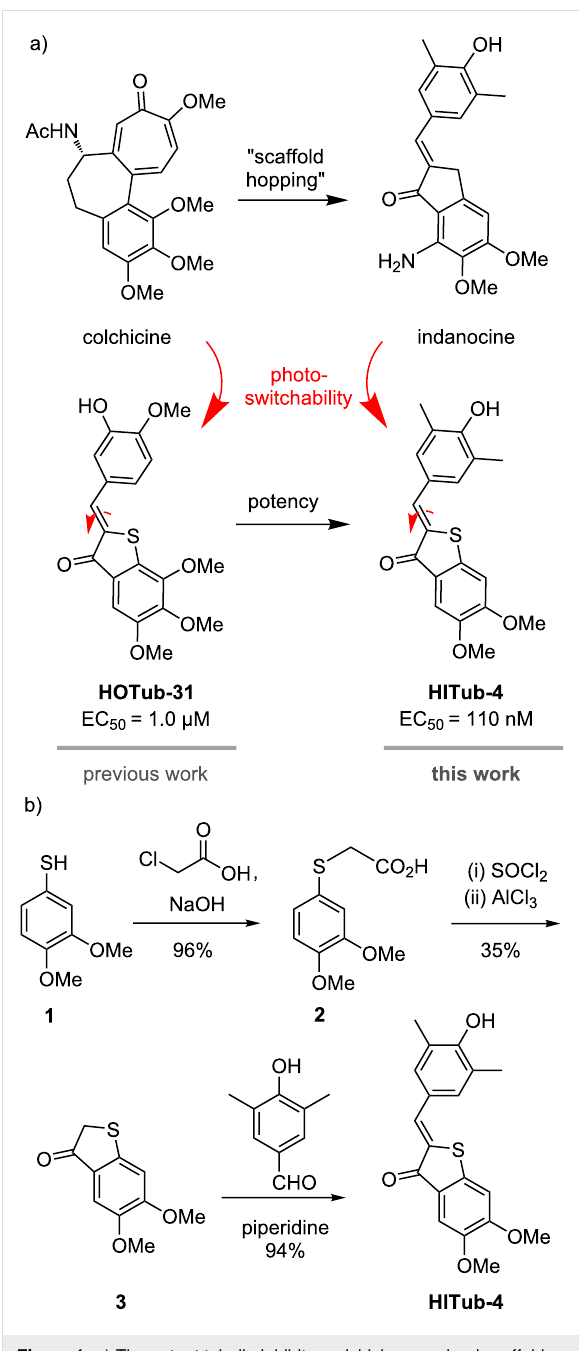
Figure 1: a) The potent tubulin inhibitor colchicine as a lead scaffold led to the development of the HOTub generation of HTI-based anti- mitotics (e.g., HOTub-31 ). Changing the lead scaffold to indanocine led to the development of up to ten times more potent HITubs (e.g., HITub-4 ). b) Straightforward, short, and high-yielding synthesis of HITub-4 .